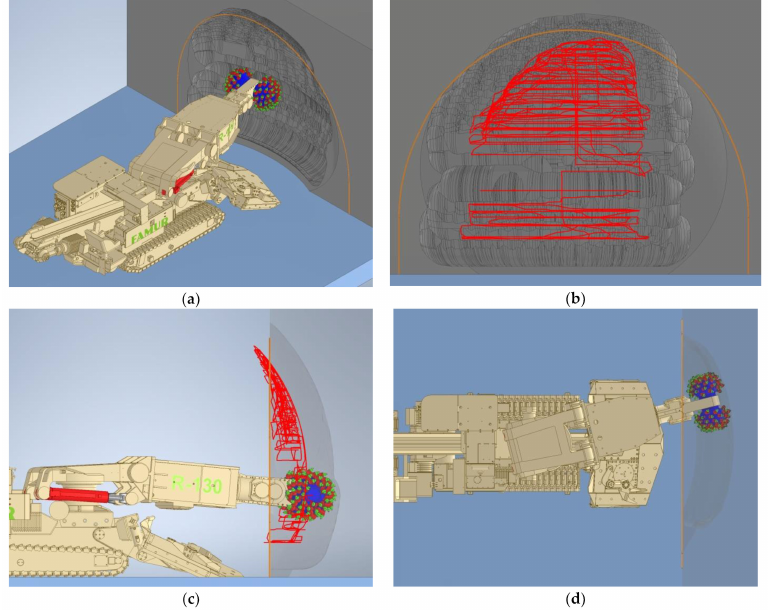
Figure 18. Visualization of the course of the real cutting process of the heading face in one cycle: ( a ) 3D view of the shape of the breakout, ( b ) projection of the trajectory of the cutting heads’ movement